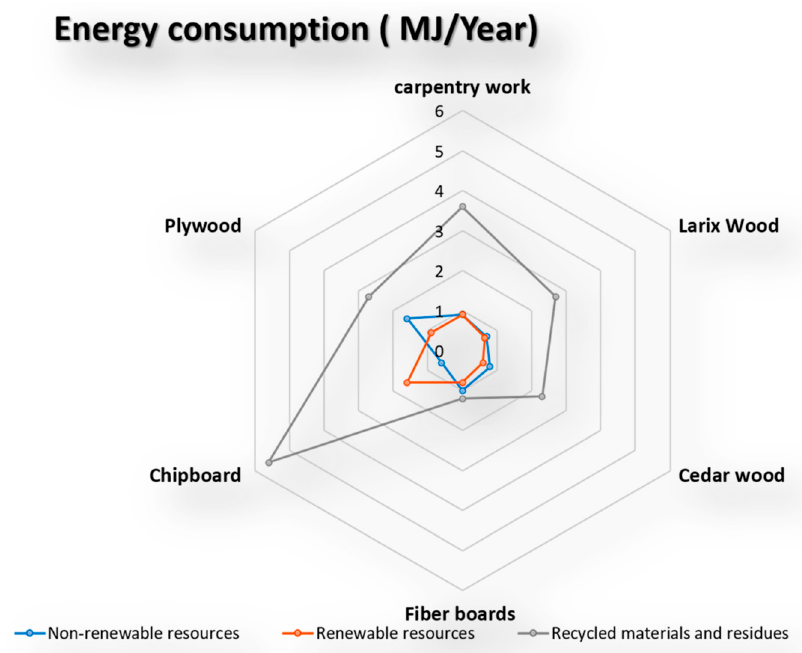
Figure 6. The impact of energy consumption on the selected façade wooden material [68–72].